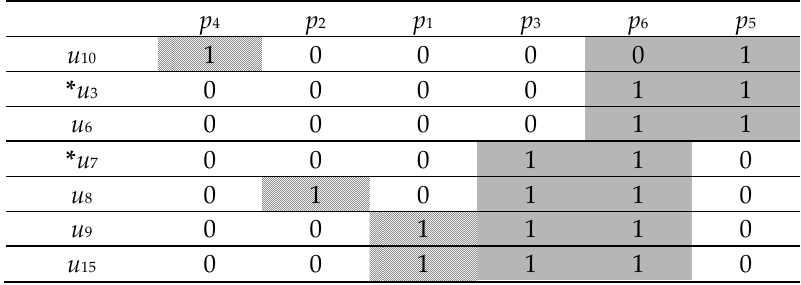
Table 6. Compressed matrix.